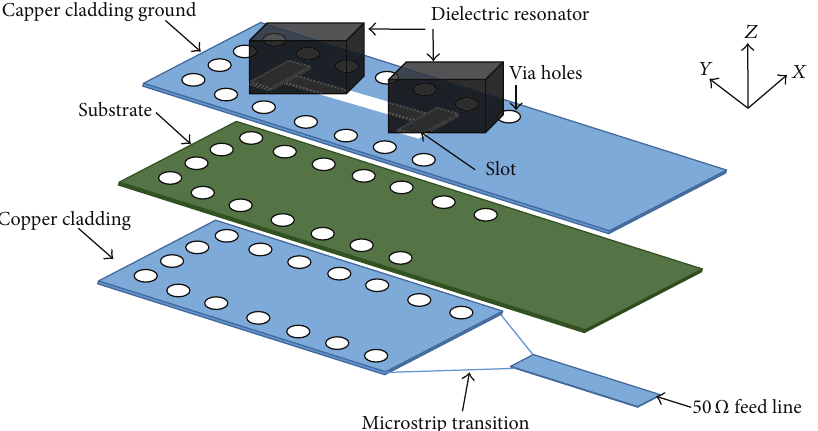
Figure 1: SIW single antenna element 3D exploded model view.